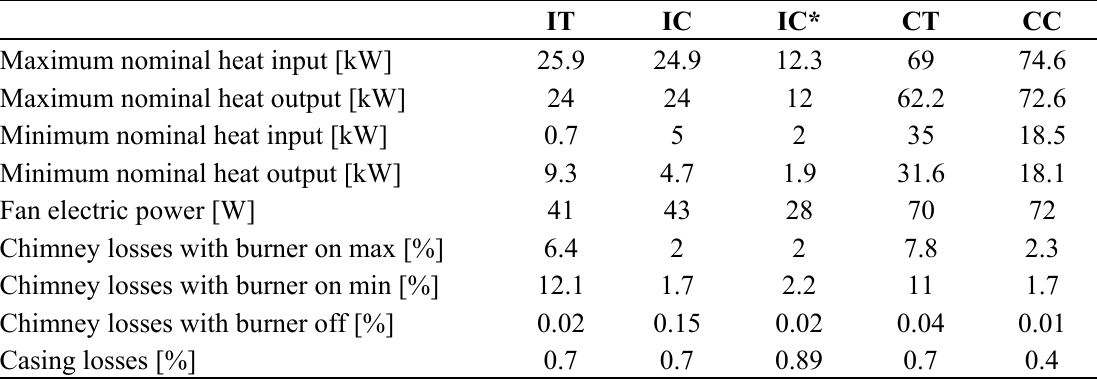
Table 2. Technical data of the considered boilers: independent traditional (IT), independent condensing (IC), independent condensing with solar plant (IC*), centralized traditional (CT) and centralized condensing (CC).